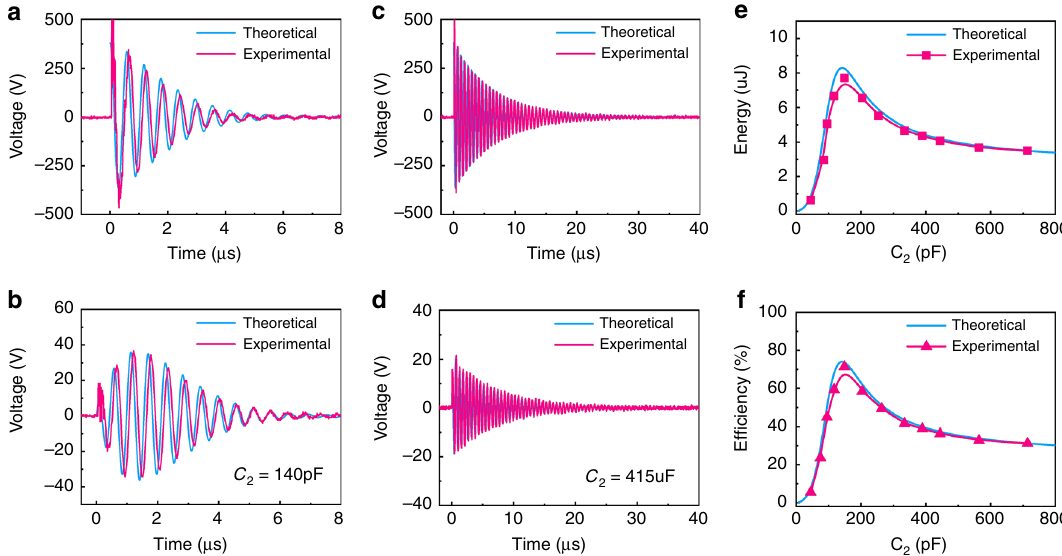
Fig. 2 In fl uence of capacitance C 2 on energy transmission. a The transmitted and b the received voltage waveforms with the system working at the resonant-coupled state. c The transmitted and d the received voltage waveforms with the system working at a nonresonant-coupled state. e The transferred energy value and f the energy transmission ef fi ciency of the MR-WTENG system as a function of C 2 . All of the experiments and theoretical analyses were conducted using the conditions shown in Table 1 with C 2 as a variable.